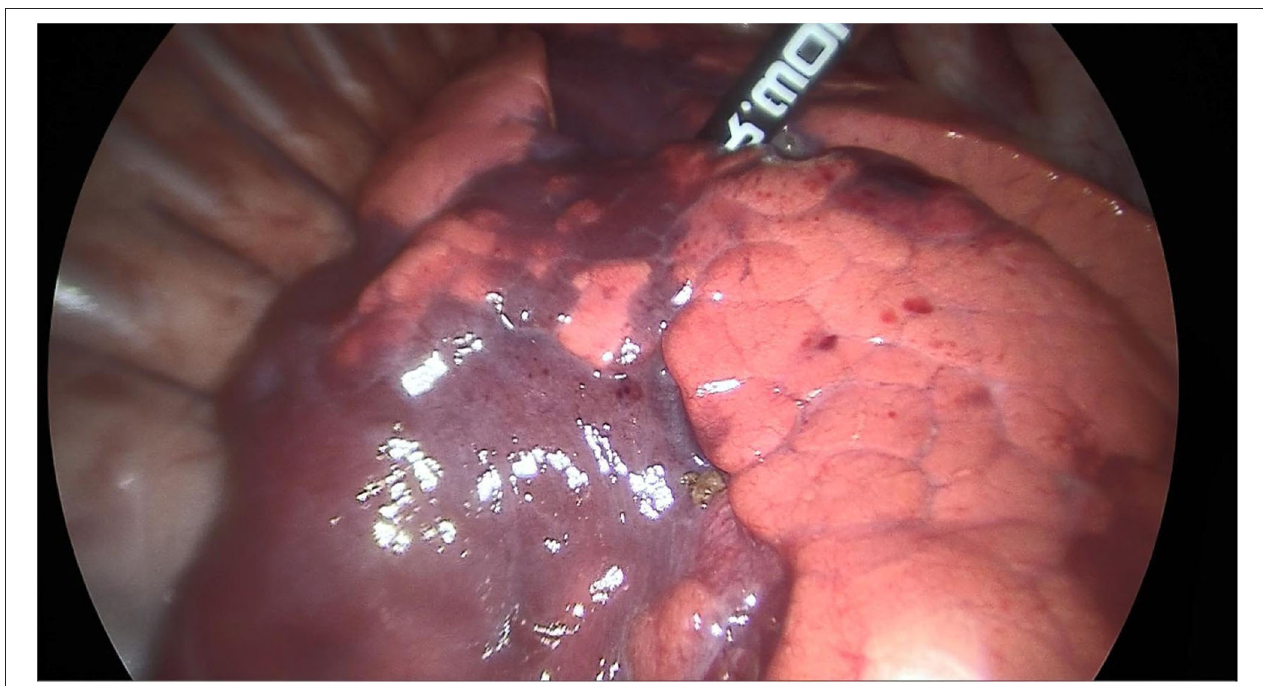
FIGURE 1 | The appearance of the line between inflation and deflation under both clamping the segmental bronchi (RS9 + 10) and inflating the lung.